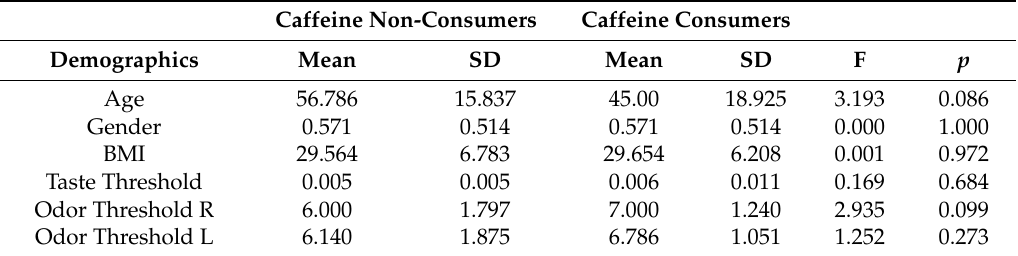
Table 1. Participant characteristics for caffeine non-consumers and matched caffeine